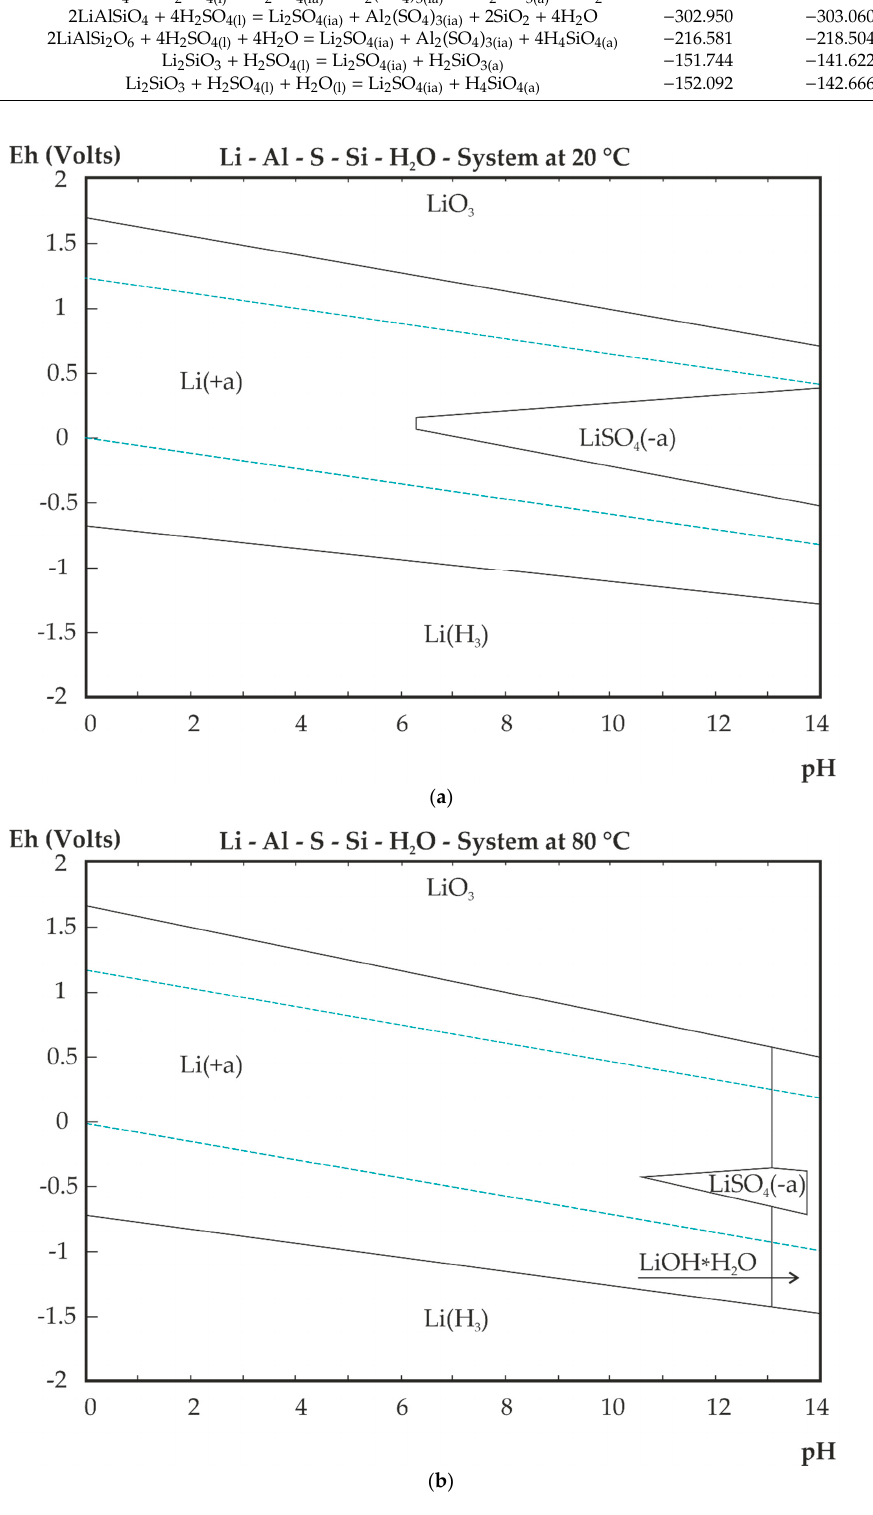
Figure 4. Eh-pH diagram for Li-Al-S-Si-H 2 O system: ( a ) 20 °C, ( b ) 80 °C. Molarity: (Li) = 1 M, (Al) = 0.5 M, (S) = 0.5 M and (Si) = 0.05 M.